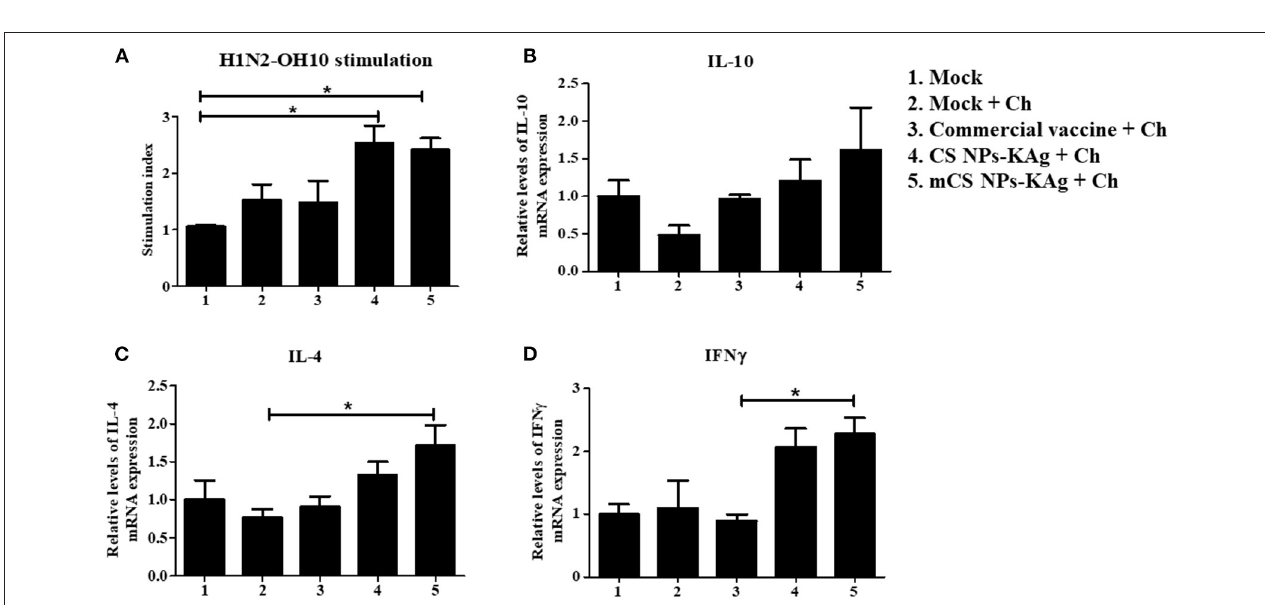
FIGURE 5 | Augmented cell-mediated immune response in MDA-positive pigs vaccinated with mannose-conjugated and unconjugated CS NPs based influenza (mCS NPs-KAg and CS NPs-KAg) vaccines and not commercial flu vaccine. At day 6 post challenge infection with H1N1-OH7 virus the isolated MNCs of tracheobronchial lymph nodes (TBLN) were stimulated with vaccine virus (H1N2-OH10). (A) Lymphocytes proliferation stimulation index in TBLN was analyzed by ELISA. TBLN tissues stored in RNAlater were analyzed by qRT-PCR for the expression of mRNA of (B) IL-10; (C) IL-4; and (D) IFN γ . Data represent the mean value of three to four pigs ± SEM. Statistical analysis was carried out using one-way ANOVA followed by Tukey’s post hoc comparison test. Asterisk refers to statistical difference between the two indicated groups (* p < 0.05). Ch,